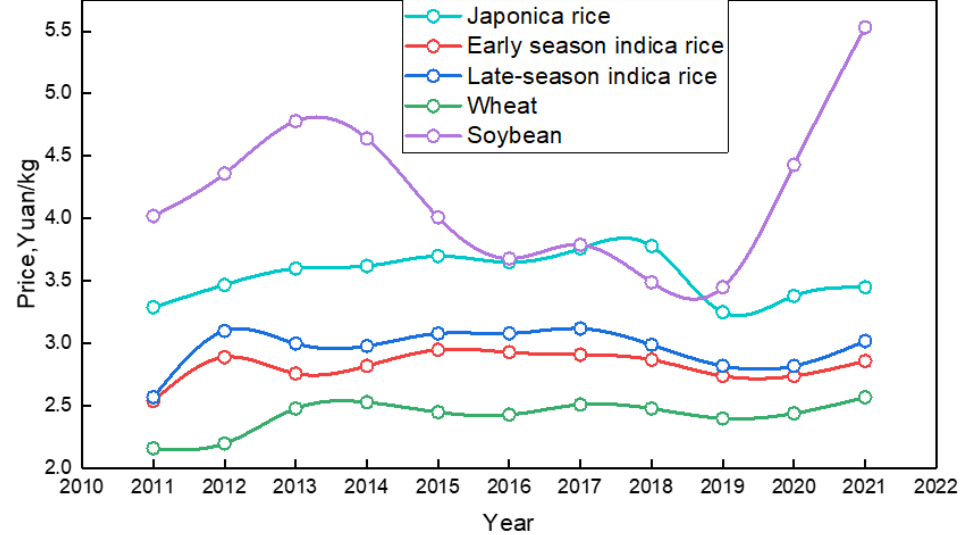
Figure 7. Annual changes of major grain purchase prices in China, 2011–2021 (Ministry of Agriculture and Rural Affairs of the People’s Republic of China)